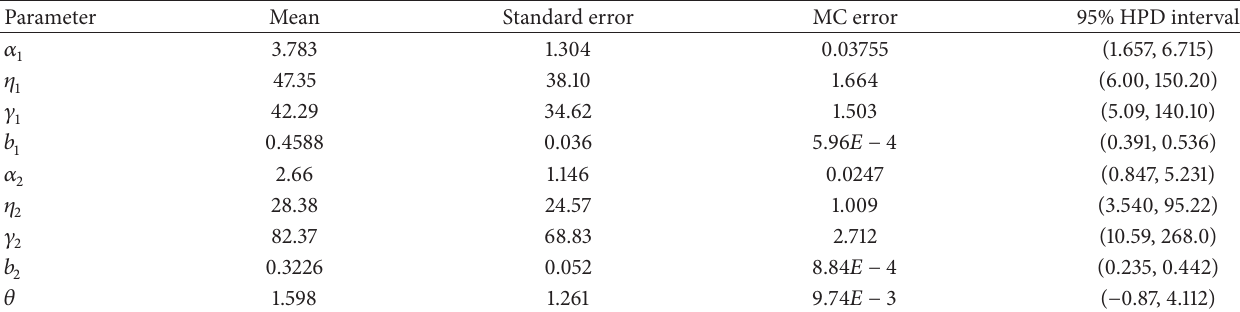
Table 2: Parameter estimation results considering the dependency.